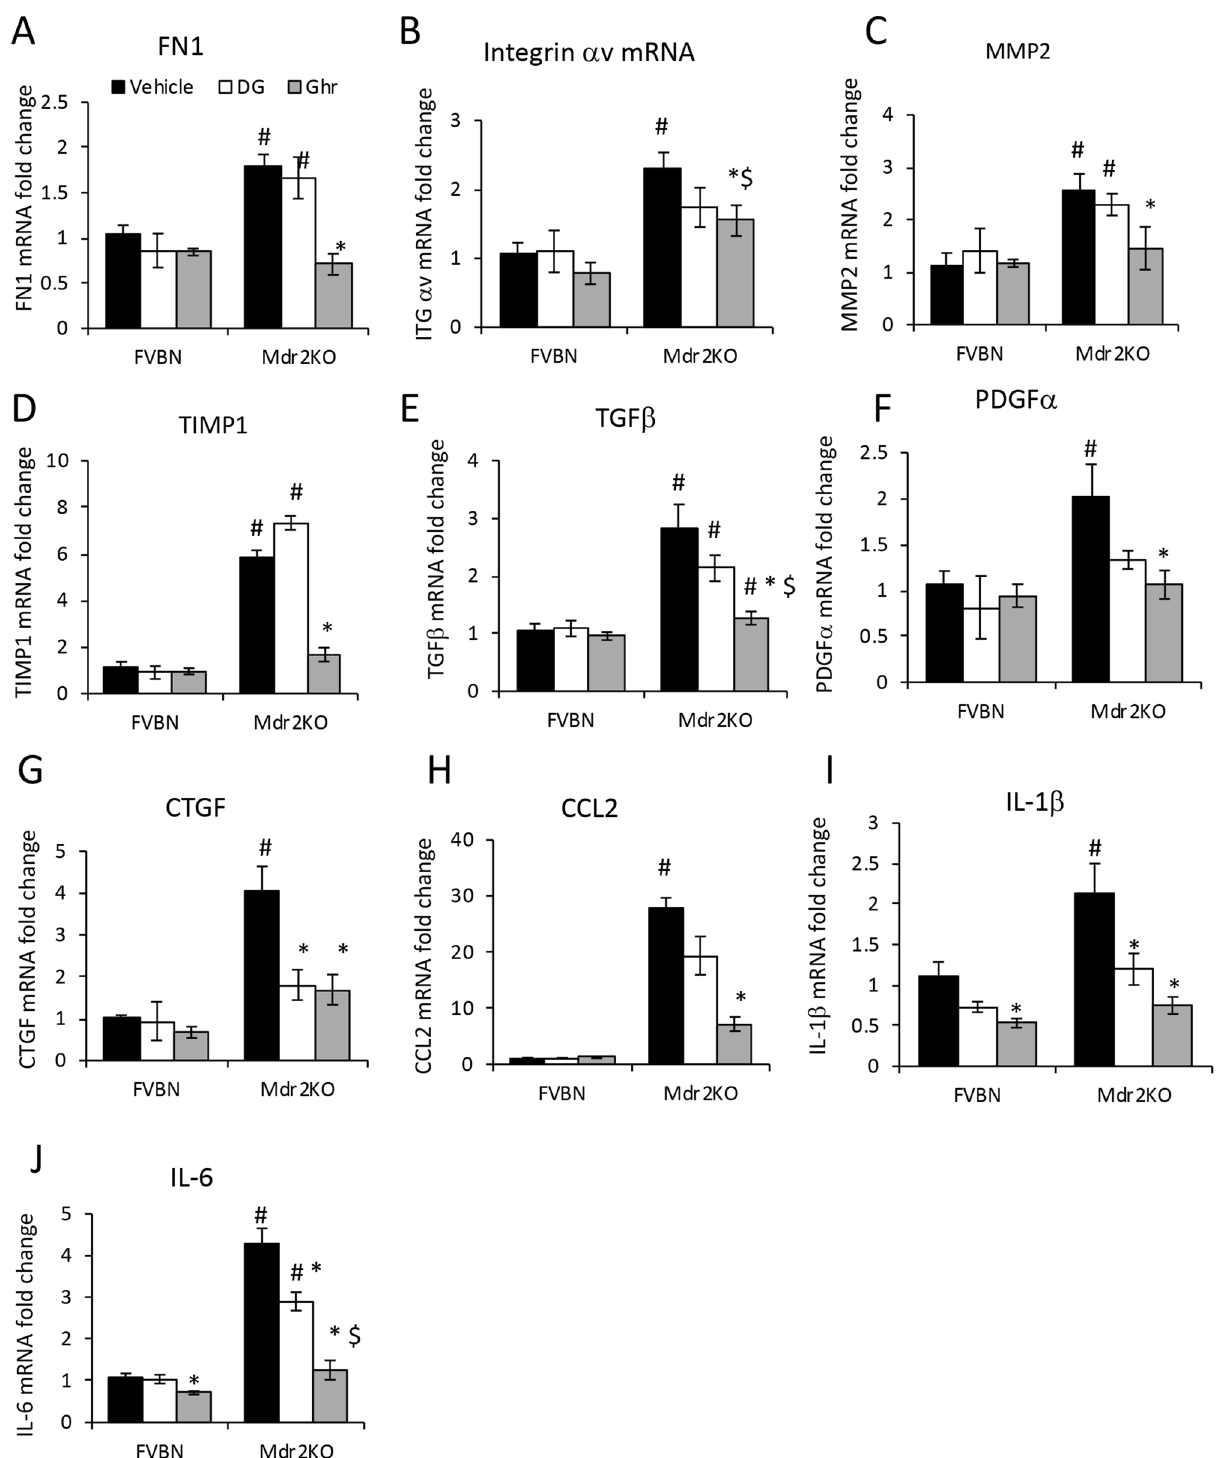
Figure 7. Ghrelin attenuates expression markers of hepatic fibrosis and inflammation in Mdr2KO mice. The expression ECM components FN1 (A) , Integrin αv (B) , MMP2 (C) and TIMP1 (D) at RNA level was performed by RT-qPCR in male Mdr2KO and FVBN mice that had been treated with vehicle, DG or Ghr. The expression of profibrogenic genes including TGFβ (E) , PDGFα (F) , CTGF (G), as well as proinflammatory cytokines CCL2 (H) , IL-1β (I) and IL-6 (J) , was also tested by RT-qPCR in the same groups. Number of animals per treatment group, 4. Number of sample replicates in RT-qPCR assay, 3. p < 0.05, *, DG or Ghr vs vehicle. #, Mdr2KO vs FVBN